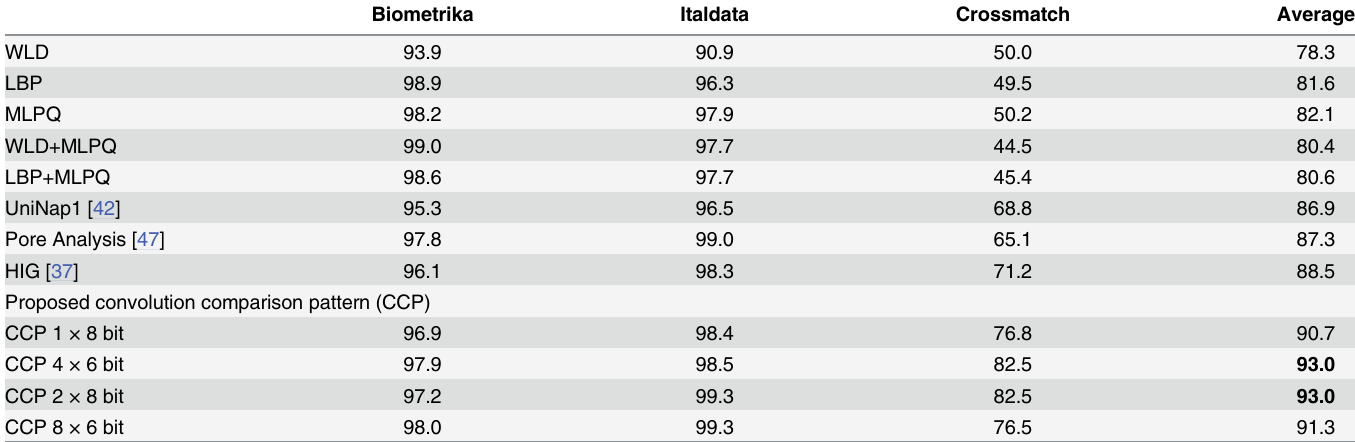
Table 1. Comparison of liveness detection methods in terms of accuracy in percent for LivDet 2013 databases [42]. Further results can be found in Table 7 of [42]. The description of CCP n × b bit can be found in Section